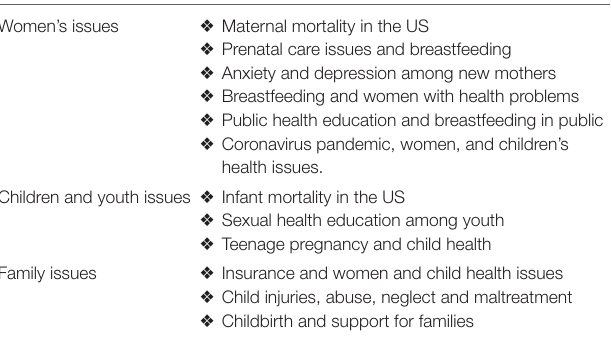
TABLE 1 | Successful topics selected by